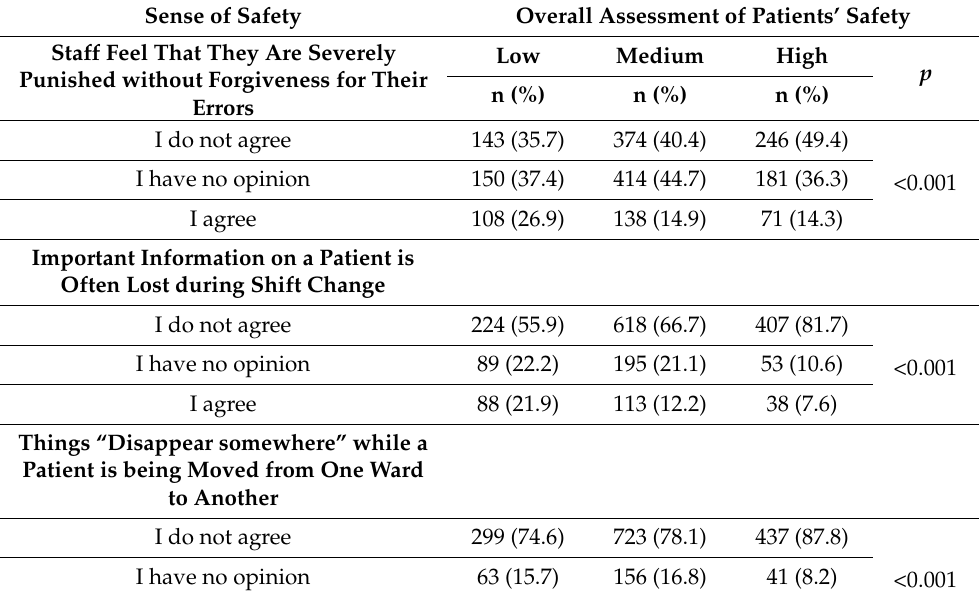
Table 3. Patients’ safety and nurses’ sense of